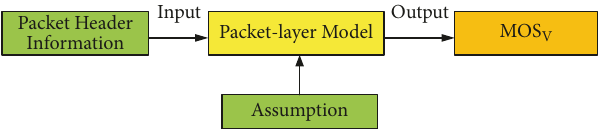
Figure 9: Conceptual view of packet layer model.